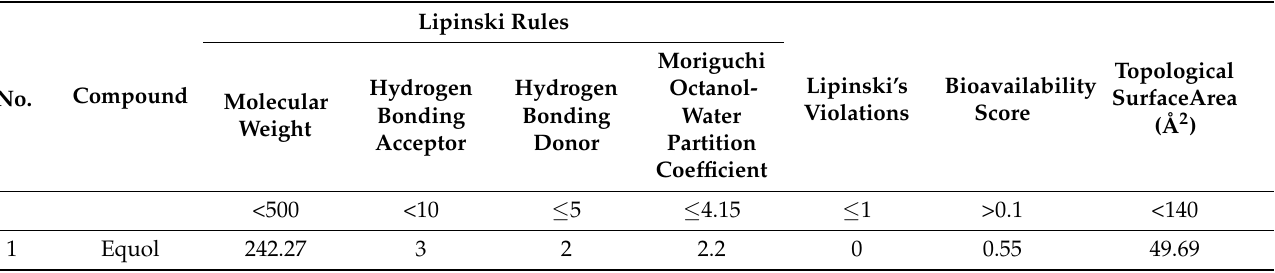
Table 5. Physicochemical properties of